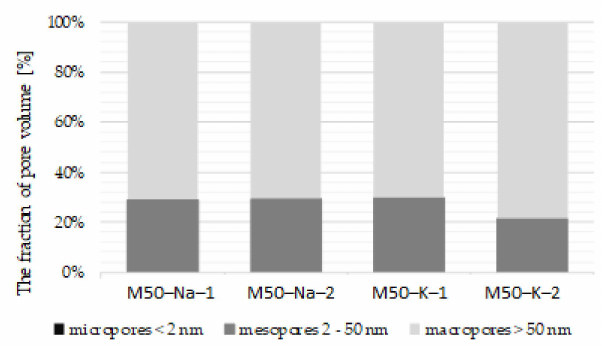
Figure 6. Types of pores (micro-, meso-, macro-) for M50-K and M50-Na materials.